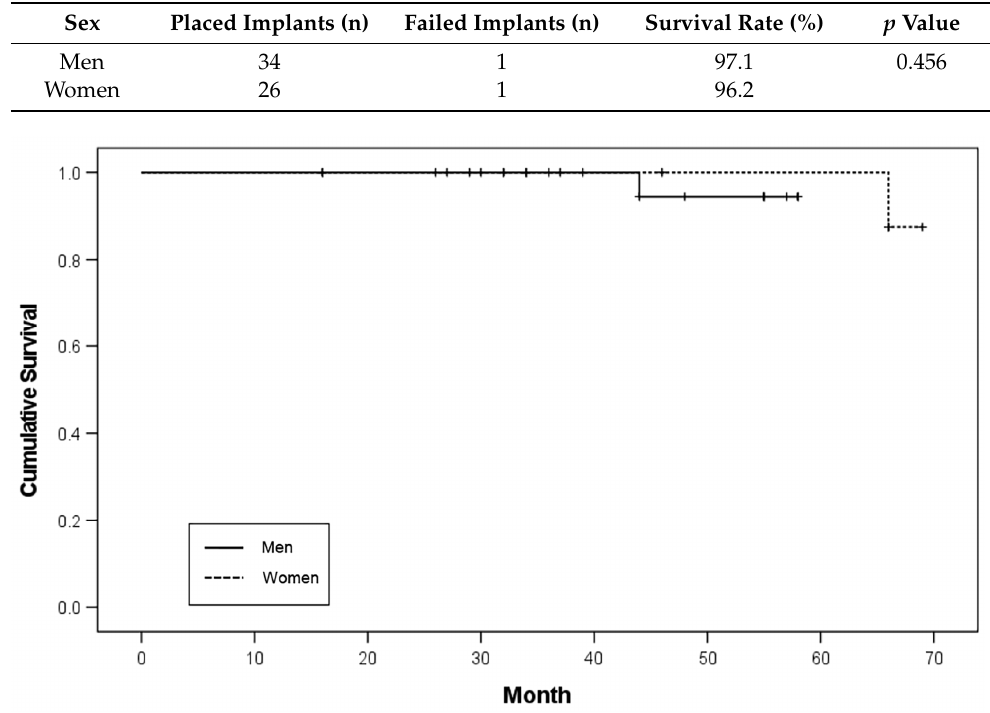
Table 2. Survival rate according to sex.